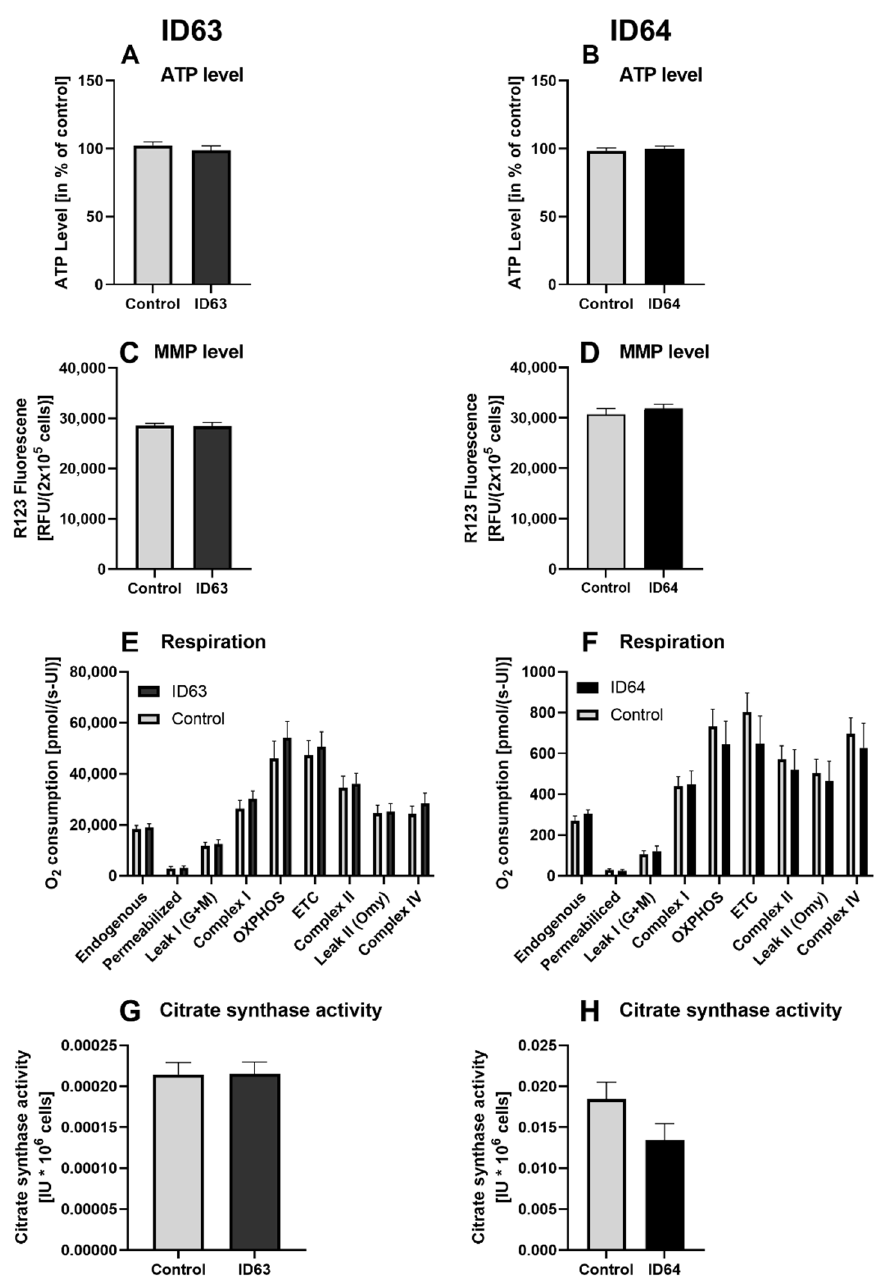
Figure 4. ATP level, MMP level, respiration and citrate synthase activity of SH-SY5Y-APP 695 cells incubated for 24 h with ID63 or ID64. ( A ) ATP level of SH-SY5Y-APP 695 cells incubated with ID63 and ( B ) ATP level of incubation with ID64 compared to the control. Cells treated with cell culture medium served as control (100%). N = 12. ( C ) MMP level of 2 × 10 5 SH-SY5Y-APP 695 cells incubated with ID63 and ( D ) MMP level of incubation with ID64 compared to the control. N = 16. ( E ) Respiration of SH-SY5Y-APP 695 cells incubated with ID63 and ( F ) incubation with ID64 compared to the control. SH-SY5Y-APP 695 cells adjusted to international units (IU) of citrate synthase activity. N = 15. ( G ) Citrate synthase activity of SH-SY5Y-APP 695 cells incubated with ID63 and ( H ) Citrate synthase activity incubated with ID64 compared to control. N = 12. Significance was determined by Student’s unpaired t -test. Data are displayed as the mean ± SEM. ID63 = 200 µM MgOr and 10 µM Fol; ID64 = 200 µM MgOr, 10 µM Fol and 100 nM Vit B6. Leak I (G + M) = leak respiration with glutamate and malate; OXPHOS = oxidative phosphorylation system; ETC = electron transport chain; Leak II (Omy) = leak respiration with olygomycin.